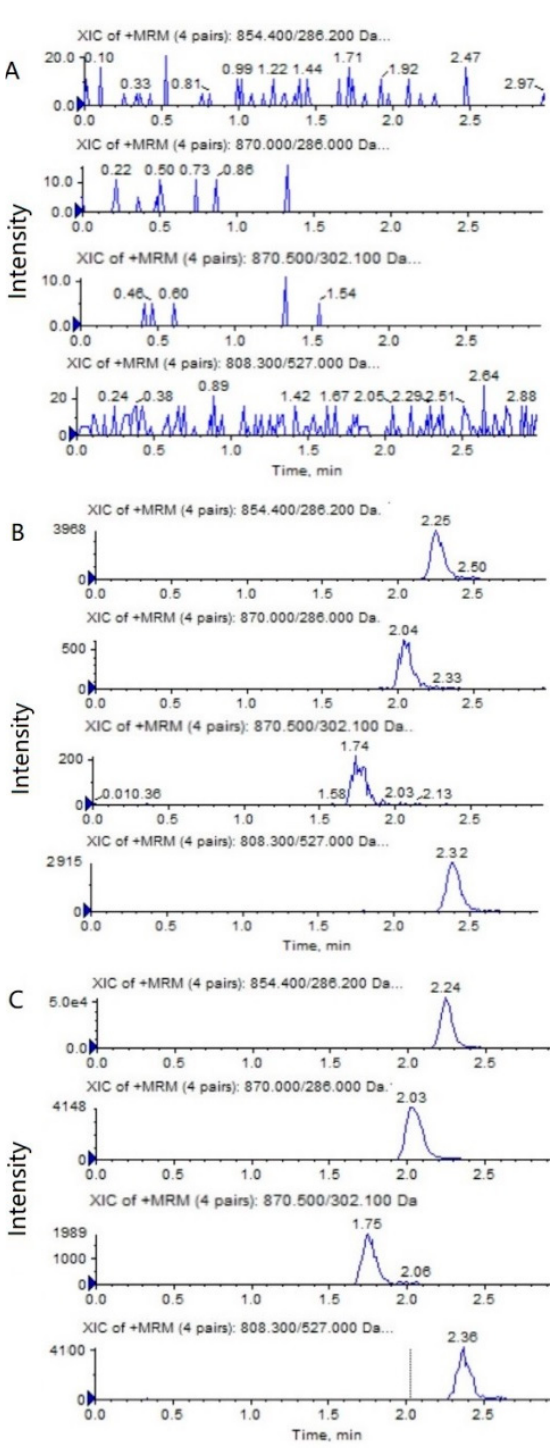
Figure 2. Representative MRM chromatograms of PTX ( m/z 854.4 → 286.2), 6 α‐ OHP ( m/z 870.0 → 286.0), 3 ′‐ OHP ( m/z 870.0 → 302.1), and DTX ( m/z 808.5 → 527.0) in mouse plasma: ( A ) a blank mouse plasma sample; ( B ) plasma samples spiked with PTX (0.5 ng/mL), 6 α‐ OHP (0.25 ng/mL), 3 ′‐ OHP (0.25 ng/mL), and the internal standard; ( C ) a mouse plasma sample following the intravenous injection of PTX solution at 5 mg/kg.